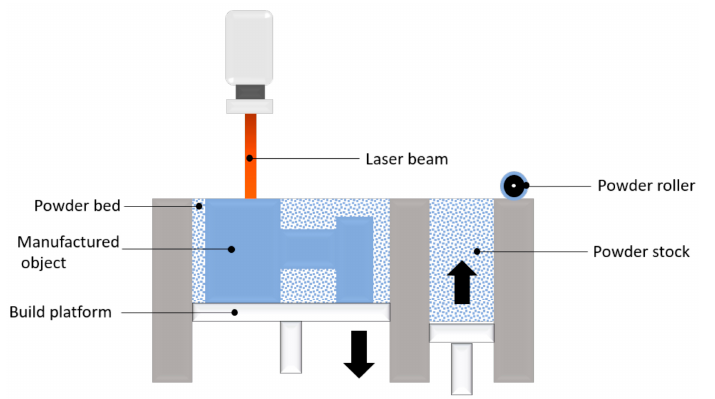
Figure 1. Schematic representation of PBF (Reused from [32] with permission in accordance with Creative Common CC BY license, open access).